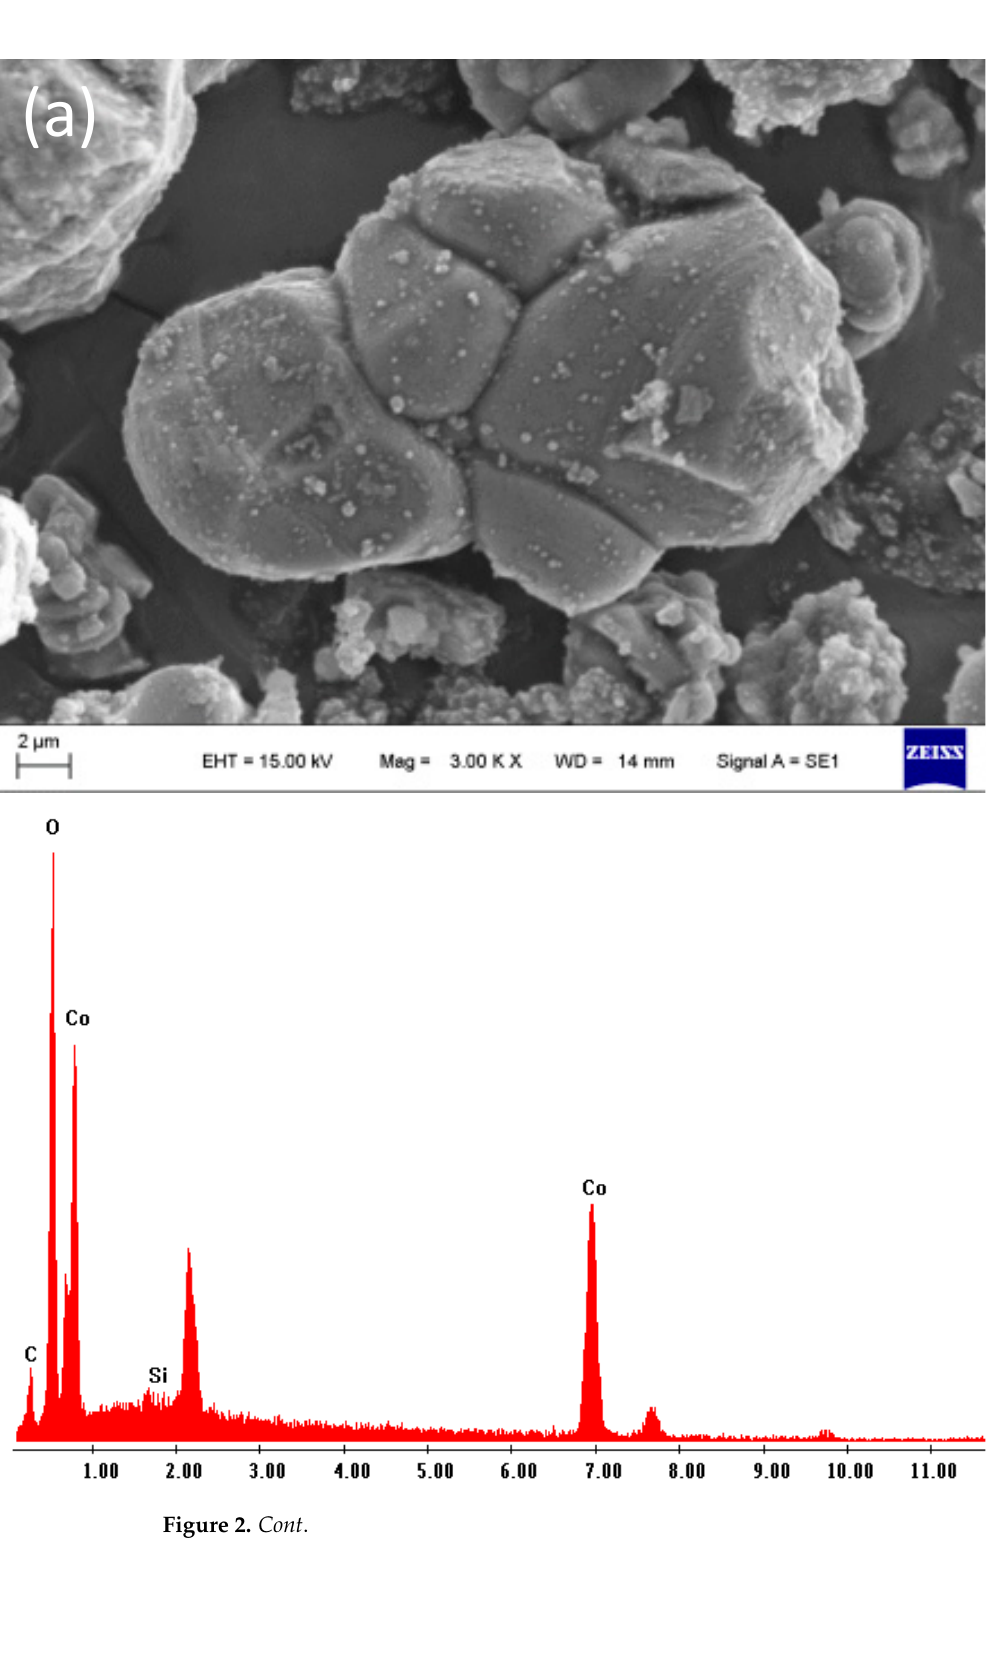
Figure 1. Diffractograms of the black mass samples from spent LIBs: ( a ) SBM, ( b ) VBM-1, and ( c ) VBM-2.